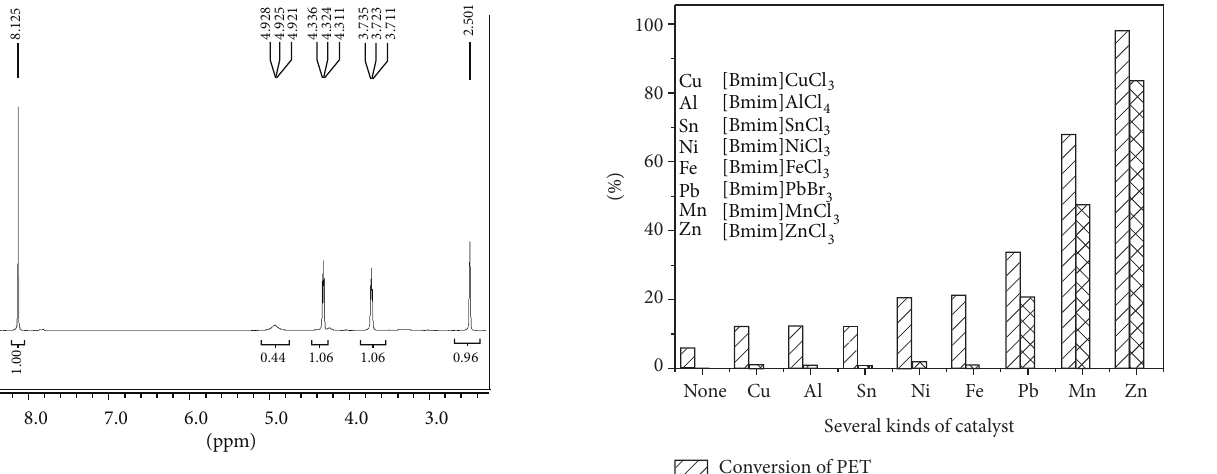
Figure 2: 1 H NMR spectra of main product of depolymerization.